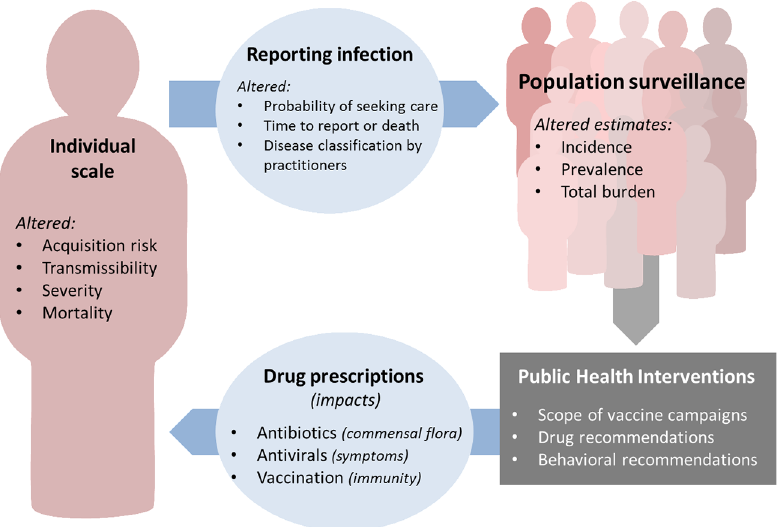
Fig 2. Cycle of factors affected by nonneutral interactions at the individual level and their impact on influenza surveillance, treatment, prevention, and control. Factors that affect coinfection on an individual scale can feed forward to an effect on population surveillance through their effects on the reporting of infection. Decisions on public health interventions are made in response to population-level data. These interventions then take effect at the individual level, to give a feedback loop both generated and impacted by effects of